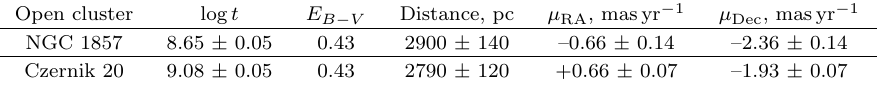
Table 2. Physical parameters of NGC 1857 and Czernik